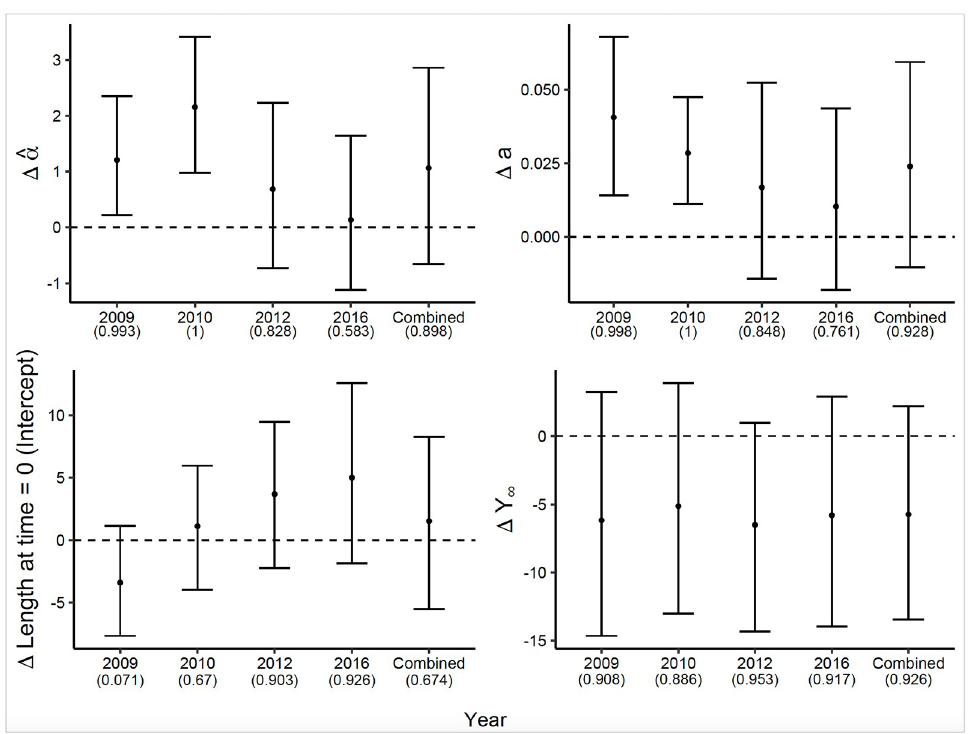
Fig 7. The difference in estimates of all model parameters ± the 95% credible interval between the two capture types of young-of-the-year steelhead (recaptures in restored habitat—recaptures in unrestored habitat). Year-specific estimates incorporate the random effect of year, and combined differences are based on the average parameter values among years. The number in parentheses represents the fraction of posterior draws for which the difference was above or below zero, depending on trend of the data. For all panels except the lower right, this represents the fraction of posterior draws above zero. Δ Length at time = 0 was substituted for model parameter Y 0 . The analysis omits 2013 owing to lack of long-term steelhead recaptures in unrestored